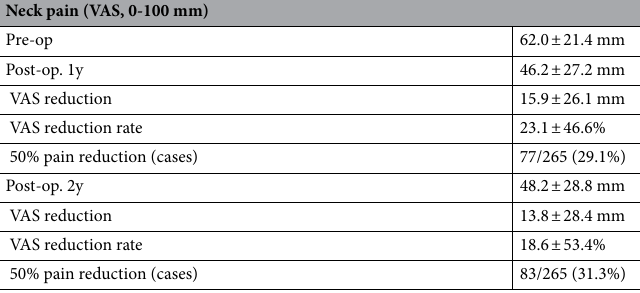
Table 2. Postoperative change of neck pain in overall participants. Pre-operative visual analogue scale (VAS 1–100 mm) neck pain score was 62.0 ± 21.4 mm on average (± SD), VAS neck pain score was reduced to 46.2 ± 27.2 mm at 1 year after surgery, therefore, post-operative 1 year VAS neck pain score reduction after surgery was 15.9 ± 26.1 mm and VAS neck pain score reduction was 23.1 ± 46.6%. VAS neck pain score 2 years after surgery was 48.2 ± 28.8 mm, post-operative 2 years VAS neck pain score reduction was 13.8 ± 28.4 mm and VAS neck pain score reduction was 18.6 ± 53.4%. Significant attenuation of neck pain, which was set to 50% reduction of VAS neck pain, was achieved in 77 out of 265 patients 1 year after surgery (29.1%) and 83 out of 265 patients 2 year after surgery (31.3%).